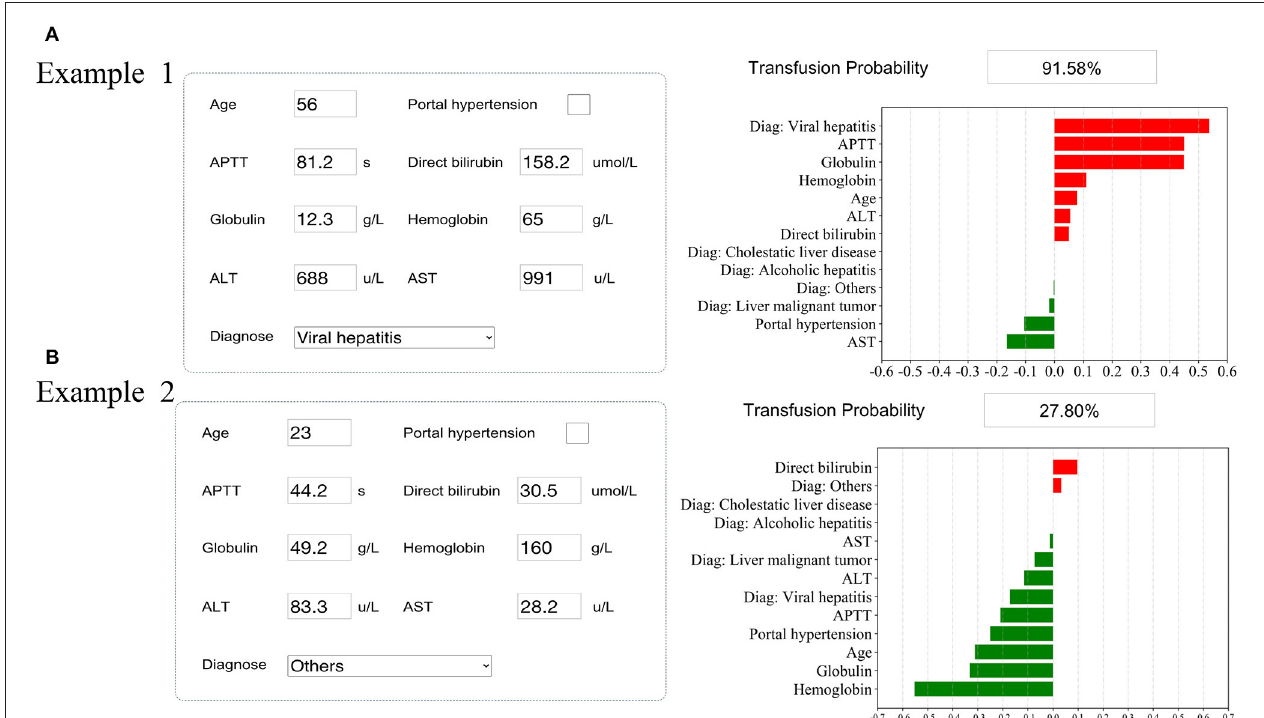
FIGURE 4 | Examples of website usage. Entering the input value determined the transfusion requirements and displayed how each value contributed to the prediction. (A) Example 1 needs RBC transfusion, and (B) Example 2 does not need RBC